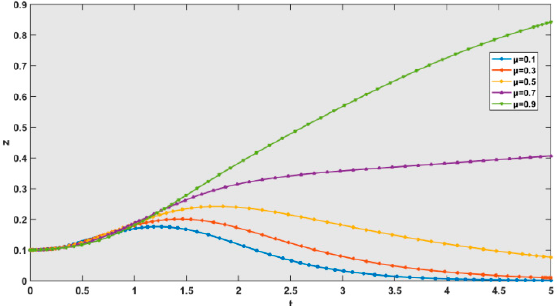
Figure 9. The influence of the change of µ on the innovation-supplying enterprises’ evolution trajectory.